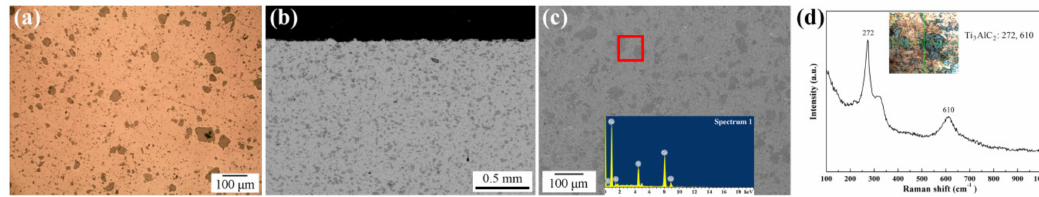
Figure 1. Original surface morphologies of Cu-20 vol.% Ti 3 AlC 2 material by ( a ) 3D LSCM, ( c ) SEM, ( d ) Raman spectrometer. ( b ) Cross-sectional image of original Cu-20 vol.% Ti 3 AlC 2 surface.